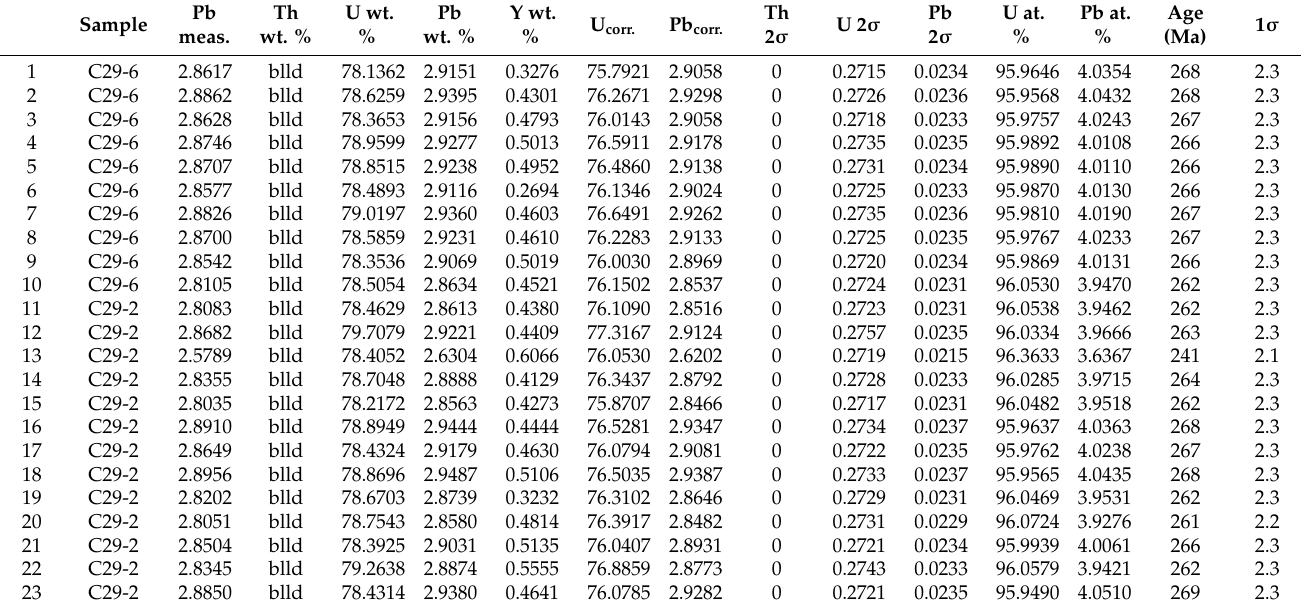
Table 3. Chemical ages of uraninite from ˇCuˇcma (Majersk á valley) calculated according to procedure of Montel et al. [29].